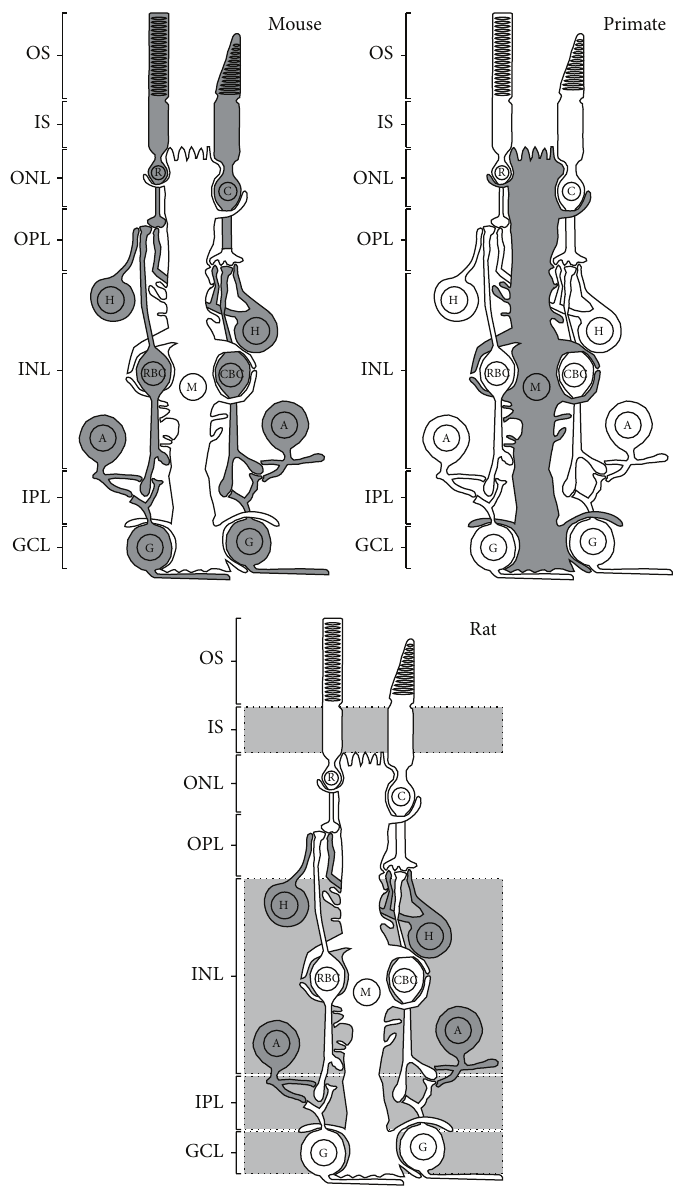
Figure 3: Schematic illustration showing the expression of CB2R in the adult retina of several species. CB1R expression was demonstrated in dark gray retinal cells, while CB2R presence was noted in light gray retinal layers without precise localization. OS, outer segments of photoreceptors; IS, inner segments of photoreceptors; ONL, outer nuclear layer; OPL, outer plexiform layer; INL, inner nuclear layer; IPL, inner plexiform layer; GCL, ganglion cell layer; C, cones; R, rods; H, horizontal cells; CBC, cone bipolar cells; RBC, rod bipolar cells;